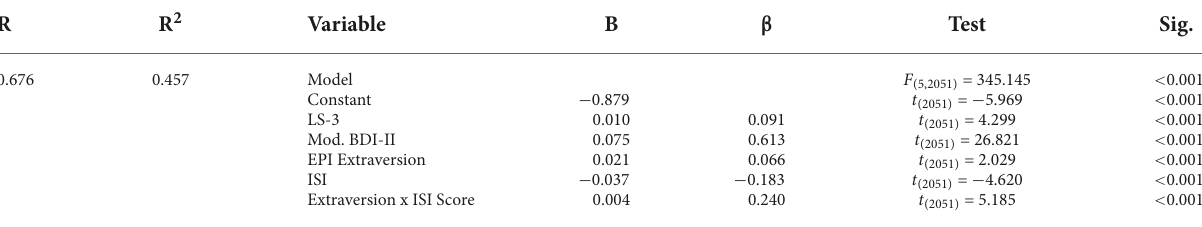
TABLE 2 Results of hierarchical linear regression predicting the combined suicidal ideation score from trait extraversion and Continuous Insomnia Severity Index (ISI) scores . R R 2 Variable B β Test